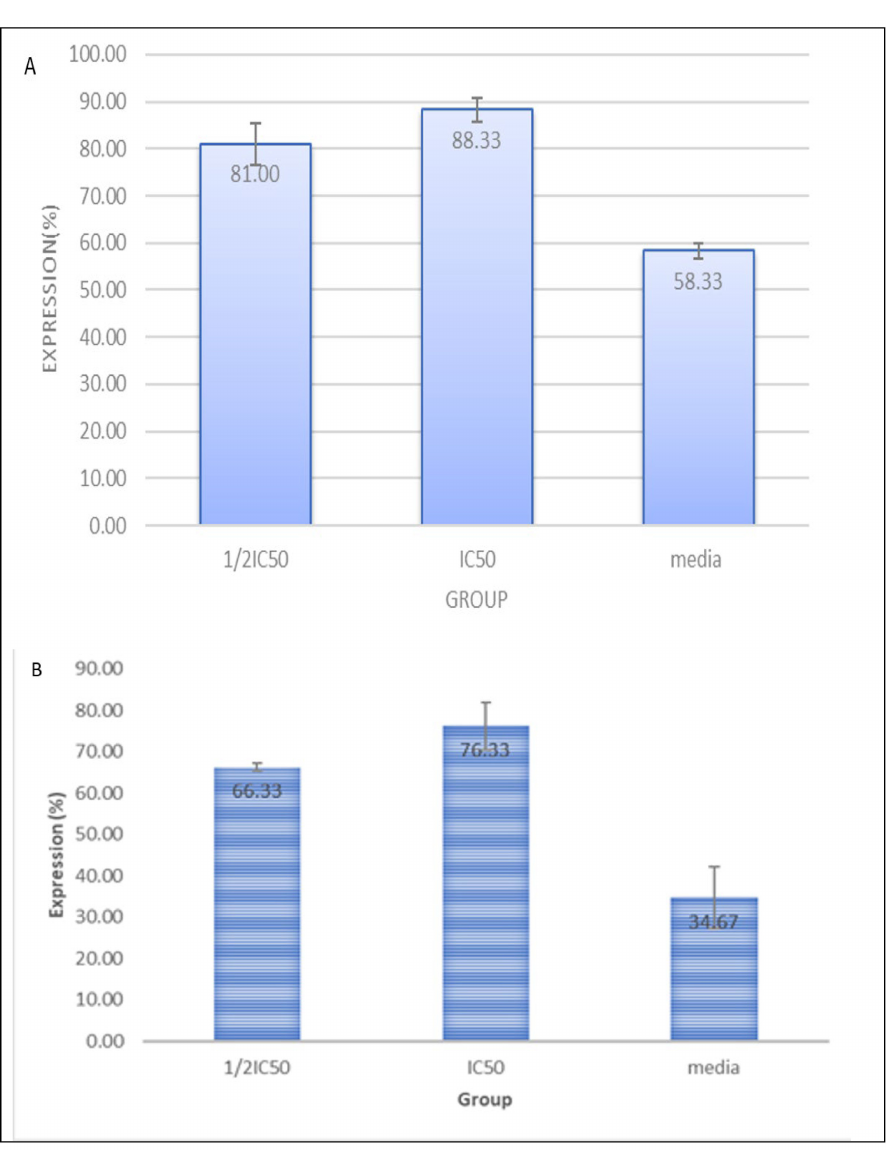
Figure 4. Expression of p53 ( A ) and Caspase-3 ( B ) in Hela cells exposed to CXBCH